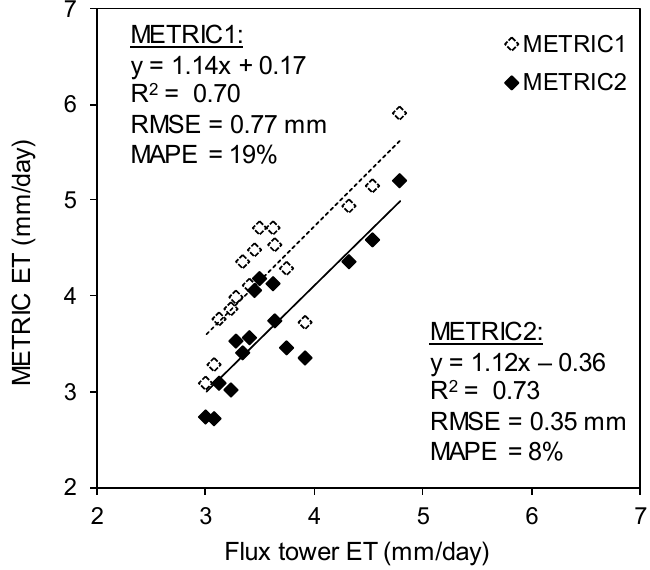
Figure 5. Overall comparison of flux-tower ET and METRIC ET obtained from Jaru Rondônia (2000–2002) and Sinop Mato Grosso (2007) by two different approaches.